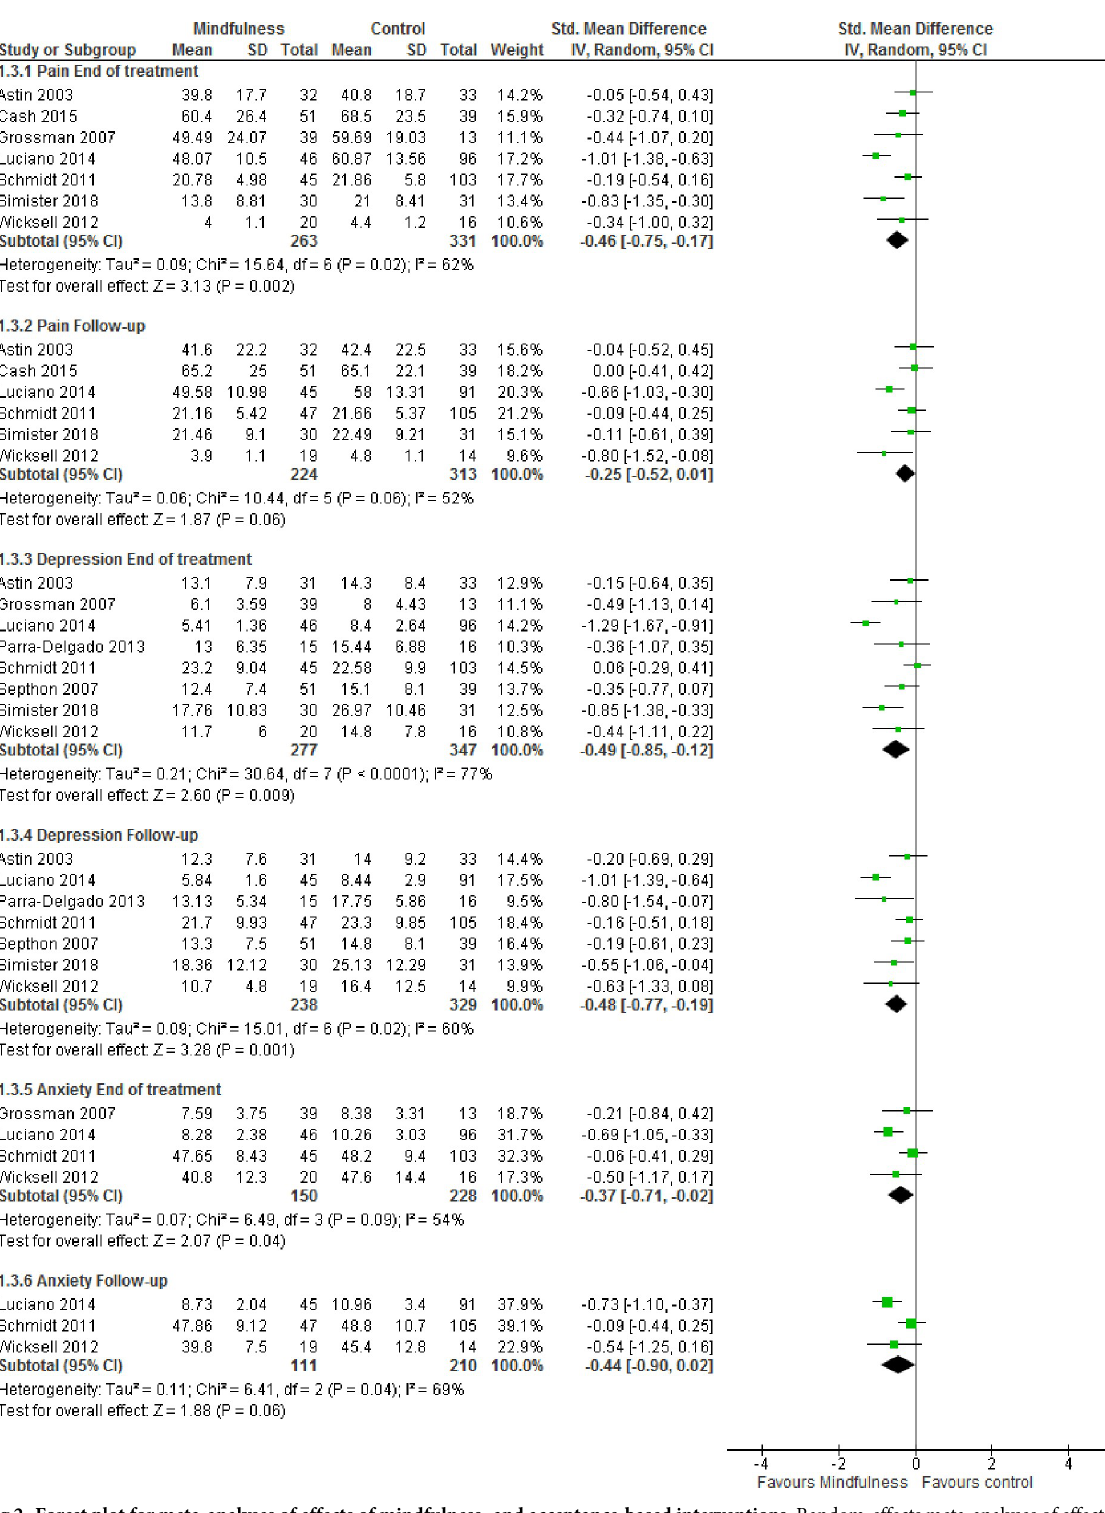
Fig 2. Forest plot for meta-analyses of effects of mindfulness- and acceptance-based interventions. Random-effects meta-analyses of effects of mindfulness- and acceptance-based interventions on pain, depression and anxiety at end of treatment (8-weeks) and follow-up (2–6